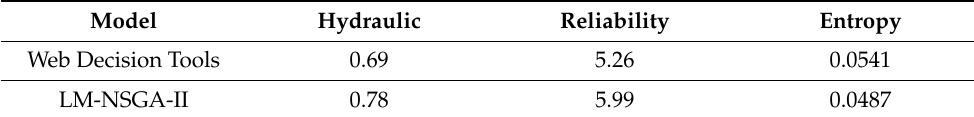
Table 2. Reliability calculation results of water supply network. Model Hydraulic